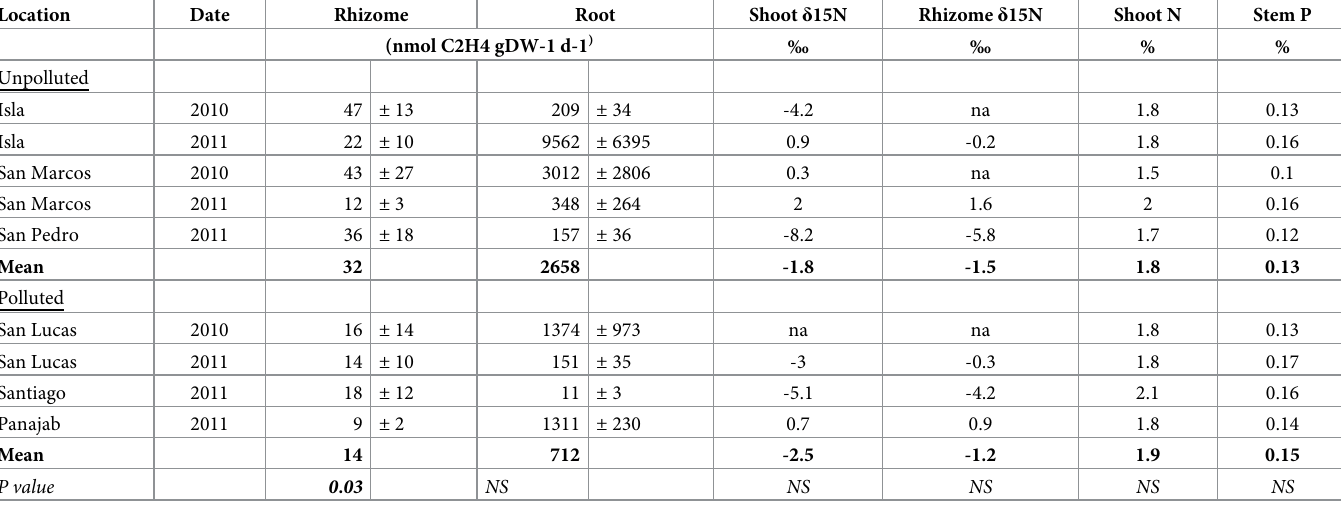
Table 4. Means ± standard deviations of nitrogenase activity of epiphytic (roots) and endophytic (rhizomes) diazotrophs measured as ethylene production (nmol